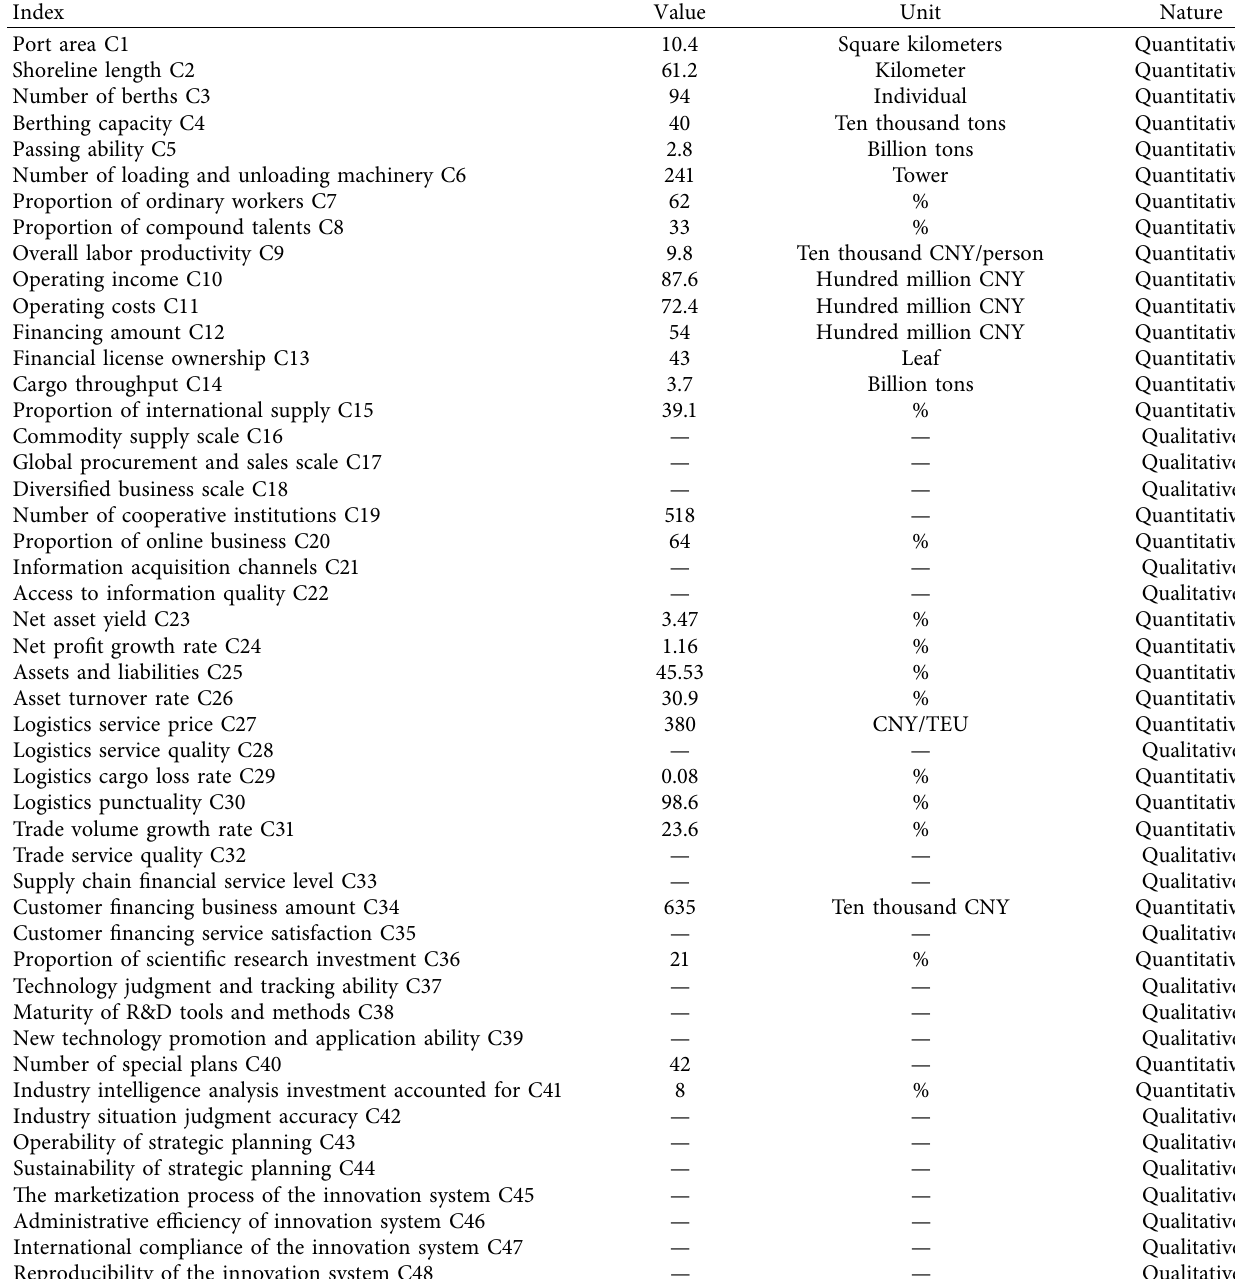
Table 2: Values for each indicator of Port